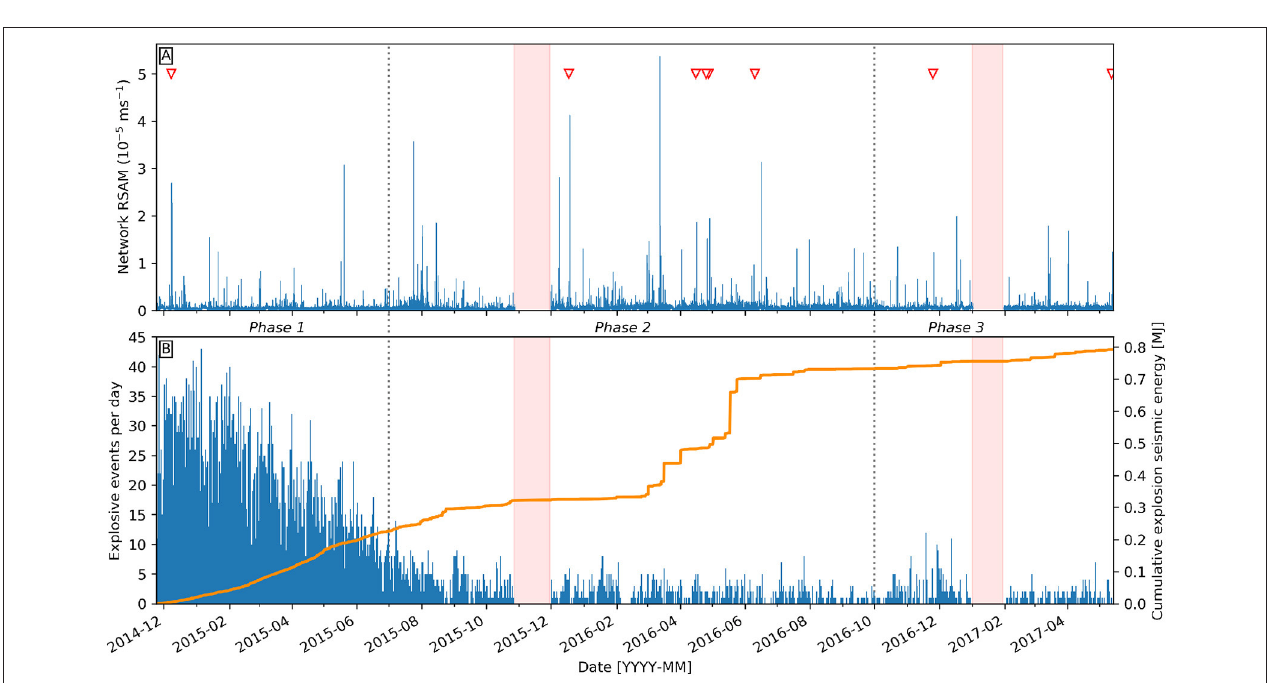
FIGURE 4 | (A) Network real-time seismic amplitude measurement (Network RSAM) between November 2014 and May 2017. Red triangles indicate M6+ tectonic earthquakes located within 800 km of Santiaguito. (B) Daily counts of explosive events detected at Santiaguito dome complex over the same time period (blue bars) and the cumulative explosion seismic energy (orange line). Periods shaded in light red indicate when no stations in the network were recording data. Dotted lines separate the three phases of eruptive activity as described in the